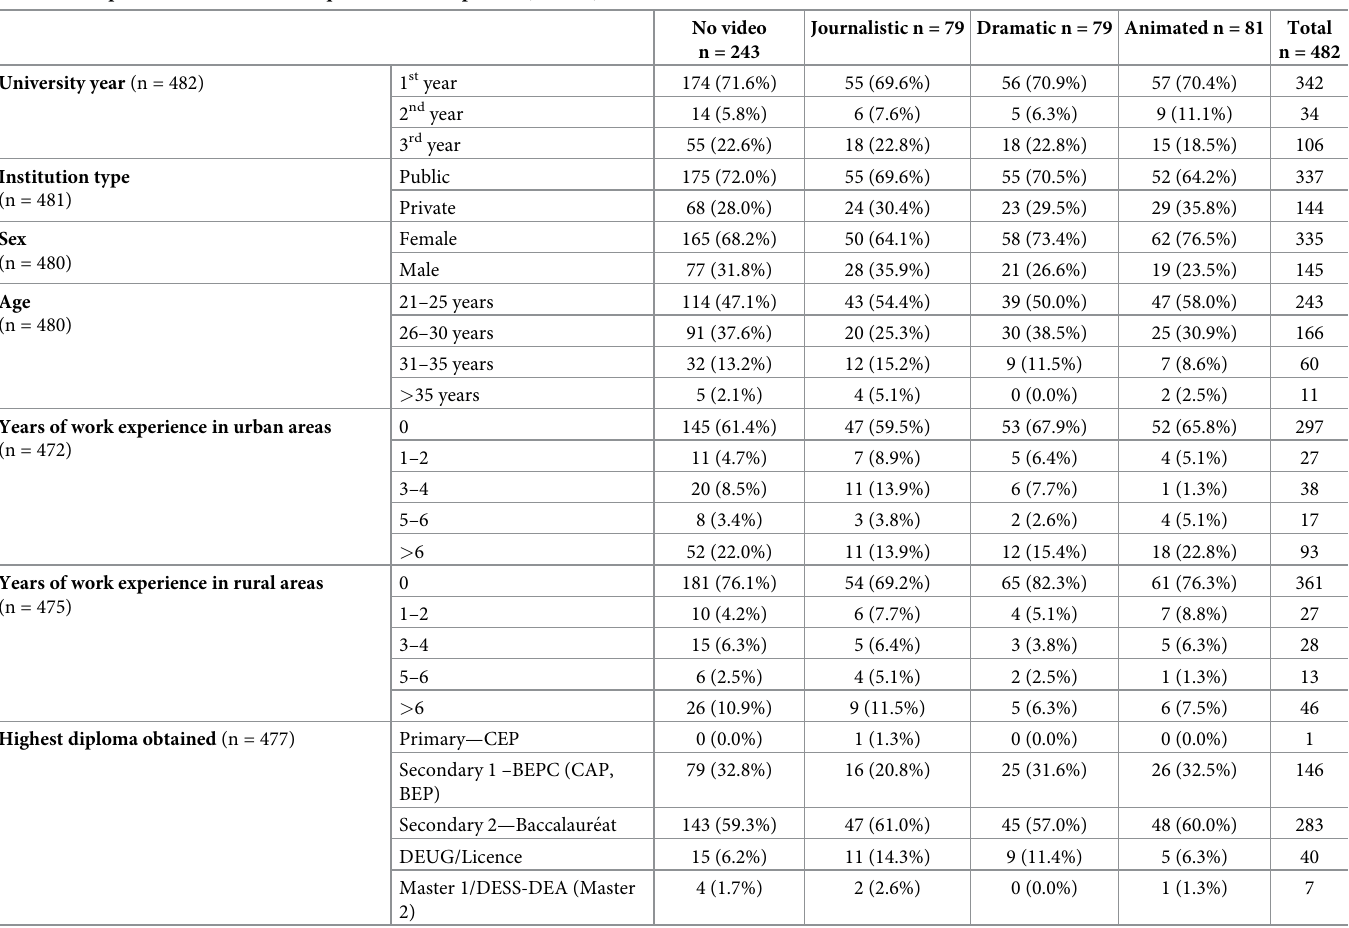
Table 1. Sample characteristics for the quantitative component (n =